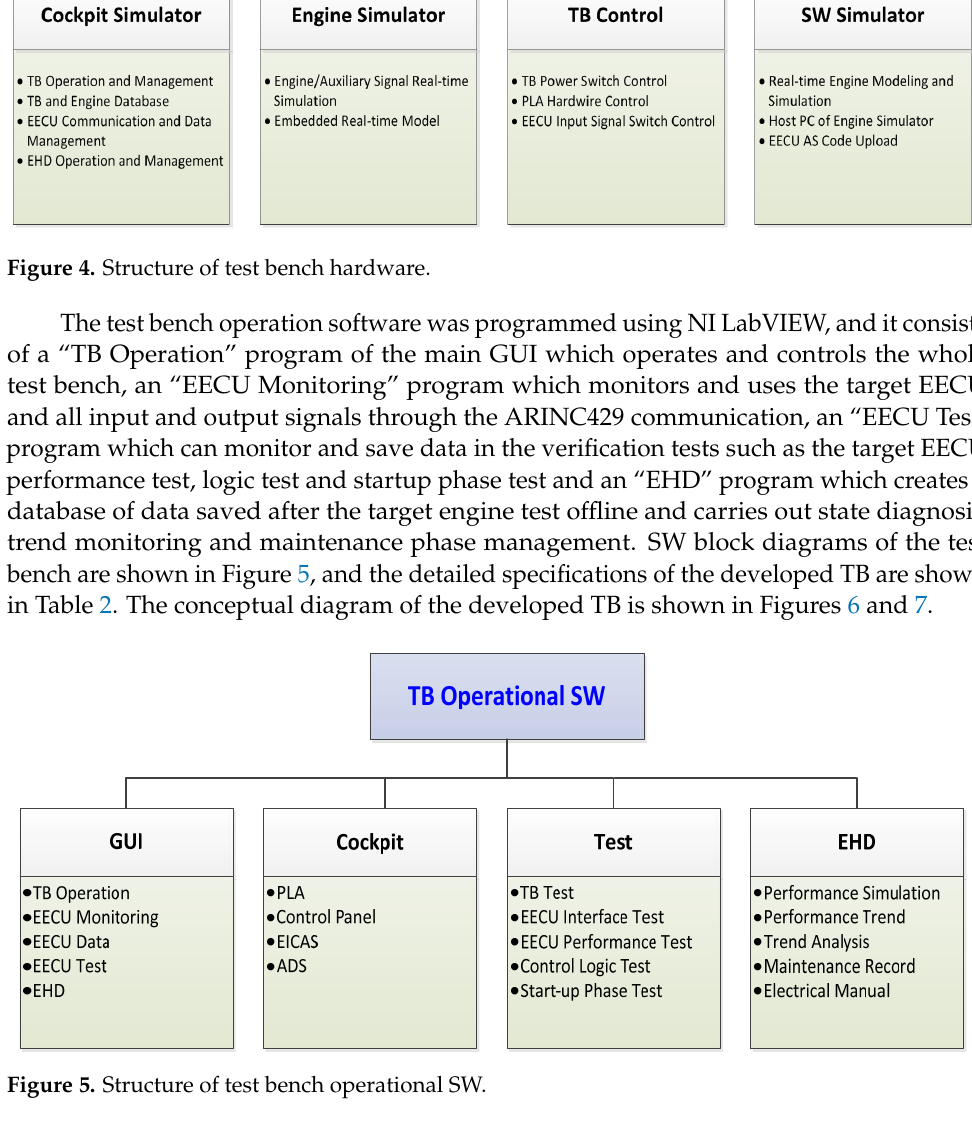
Figure 5. Structure of test bench operational SW.